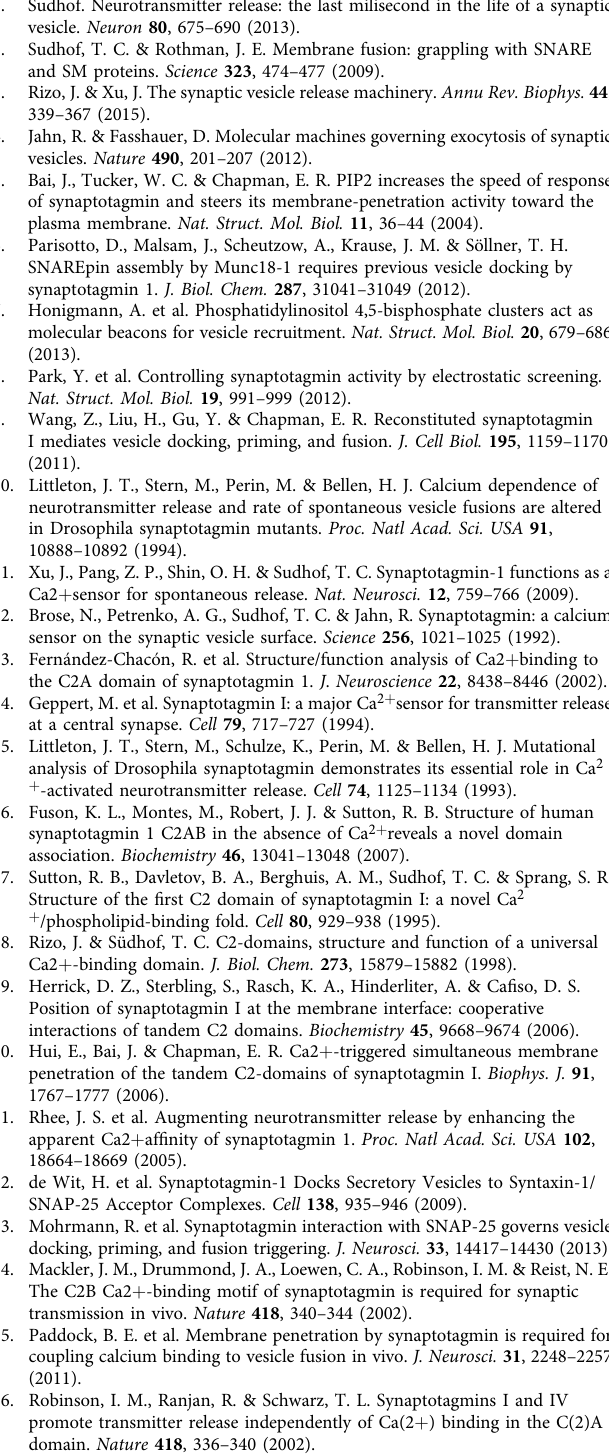
Fig. 4a-d and Supplementary Figs 6, 7 and 10A are provided as a Source Data fi le. Other data are available from the corresponding authors upon reasonable